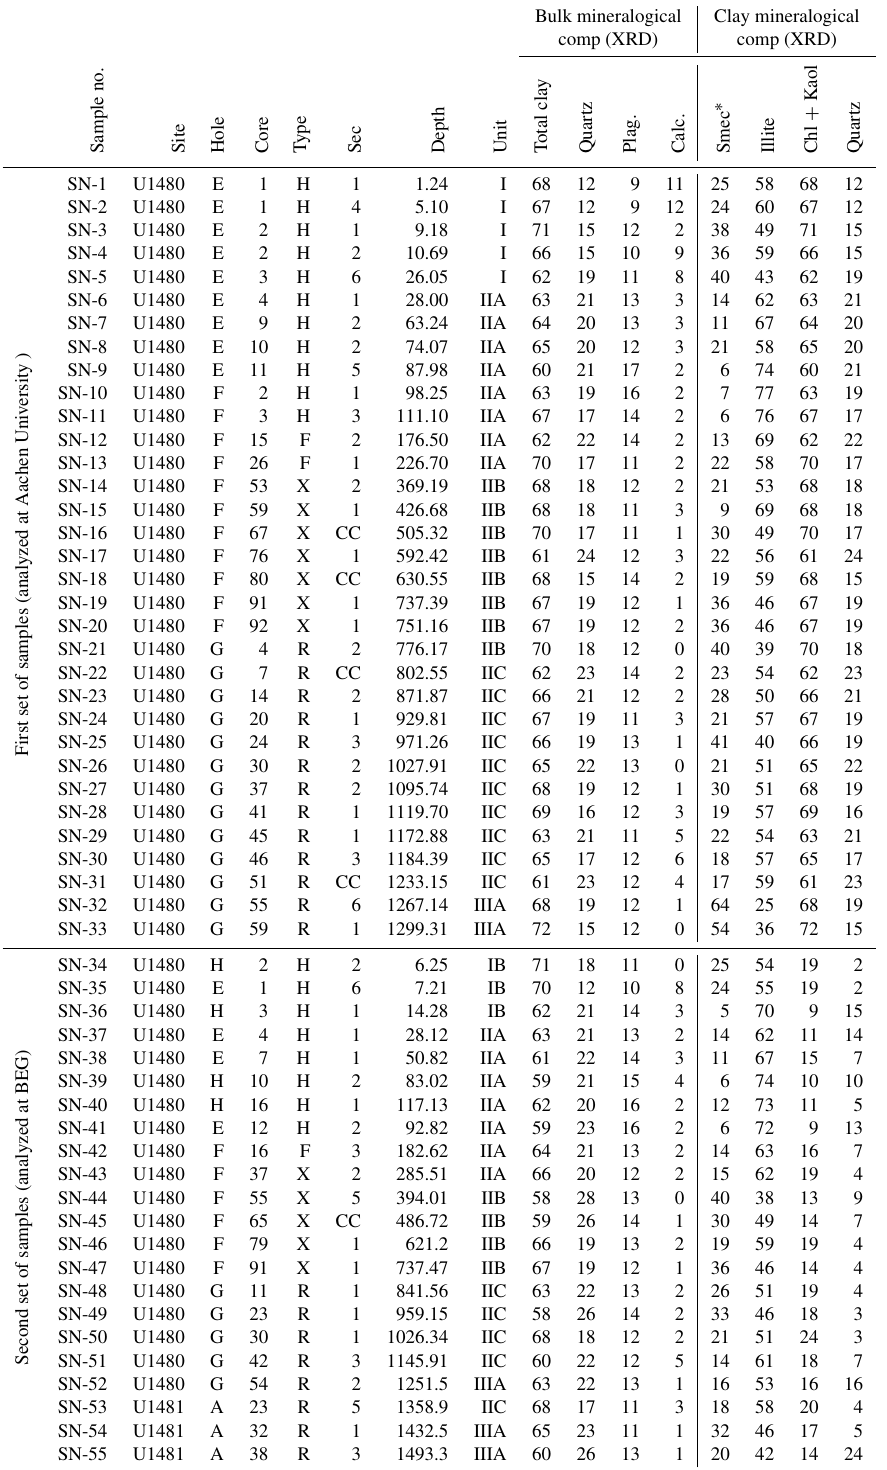
Table 1. Core description, bulk mineralogy (McNeill et al., 2017b), and clay composition (Rosenberger et al., 2020) of the analyzed samples. Bulk measurements were done shipboard on Expedition 362 (McNeil et al., 2017a; Underwood et al., 2020). Additional clay mineralogical analysis was done on the < 2µm particle fraction onshore using a different instrument and methodology (Rosenberger et al., 2020). Plag: plagioclase feldspar, Smec: smectite ∗ , Chl: chlorite, Kaol: kaolinite, Calc: